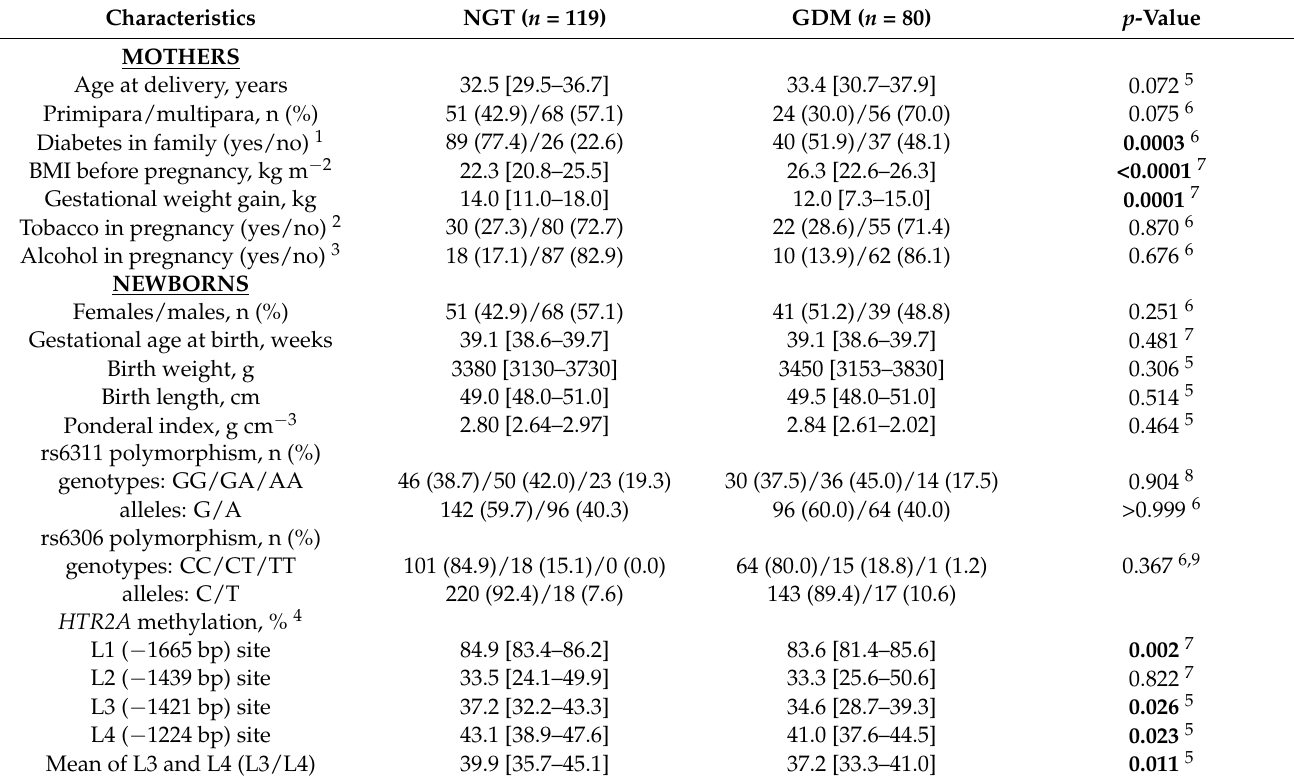
Table A1. Characteristics of the study sample according to glucose tolerance status of the mother.